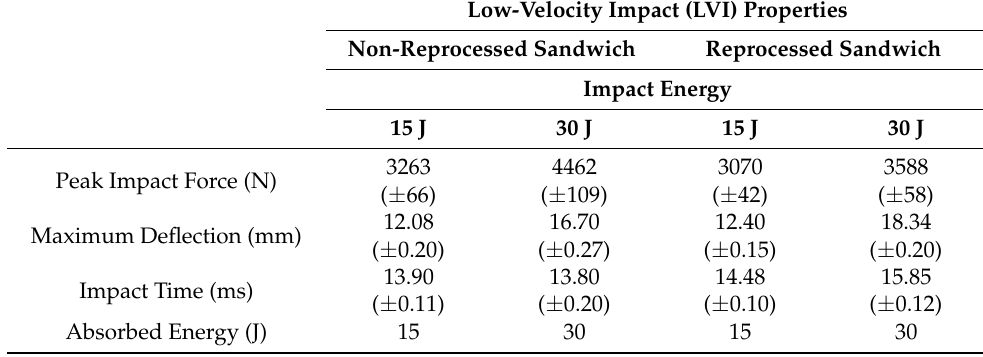
Table 2. Low-velocity impact (LVI) properties of sandwich